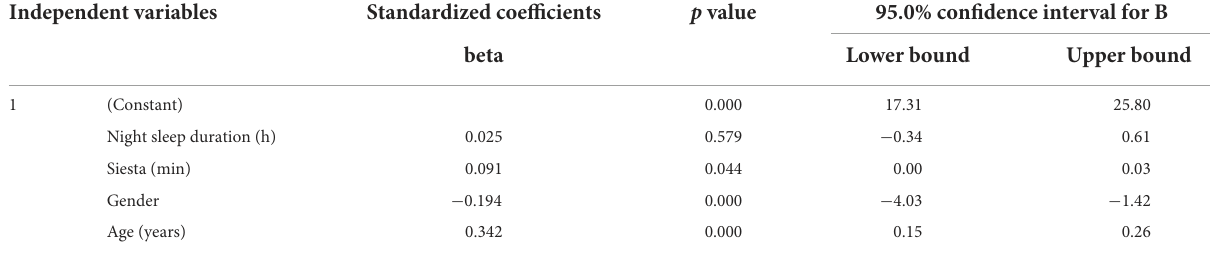
TABLE 4 Linear regression analysis of BMI (kg/m 2 ) with different confounding variables.